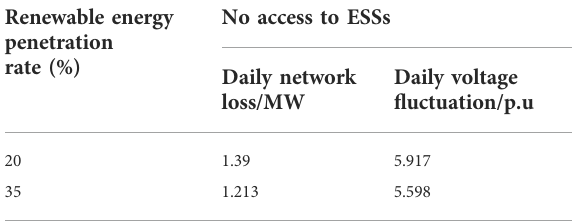
set. The fl owchart diagram of the MOPSO used for hybrid electric-hydrogen energy storage system is shown in Figure 1.